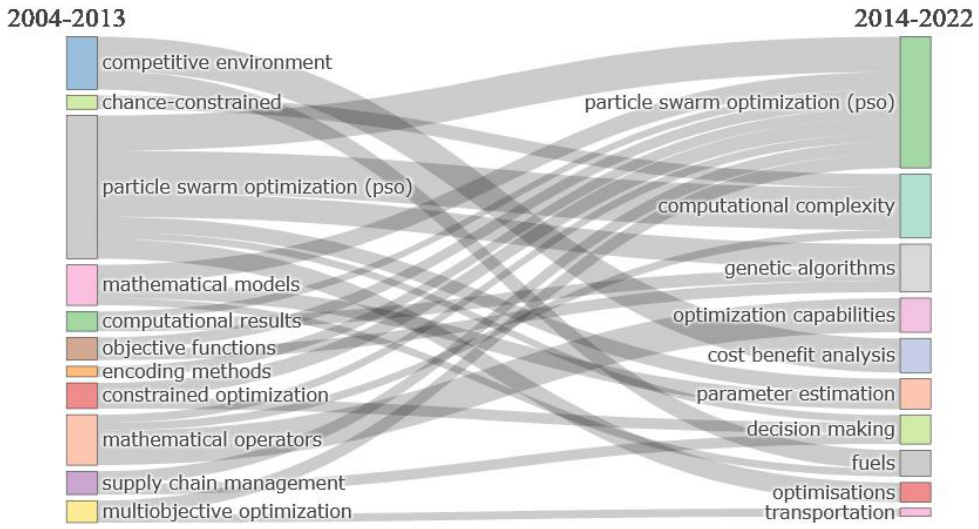
Figure 8. PSO/VRP Publication Thematic Evolution, measured by Scopus Keywords Plus